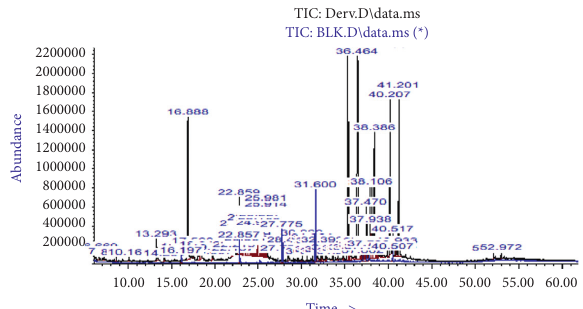
Figure 1: Chromatogram of the Galenia africana extract